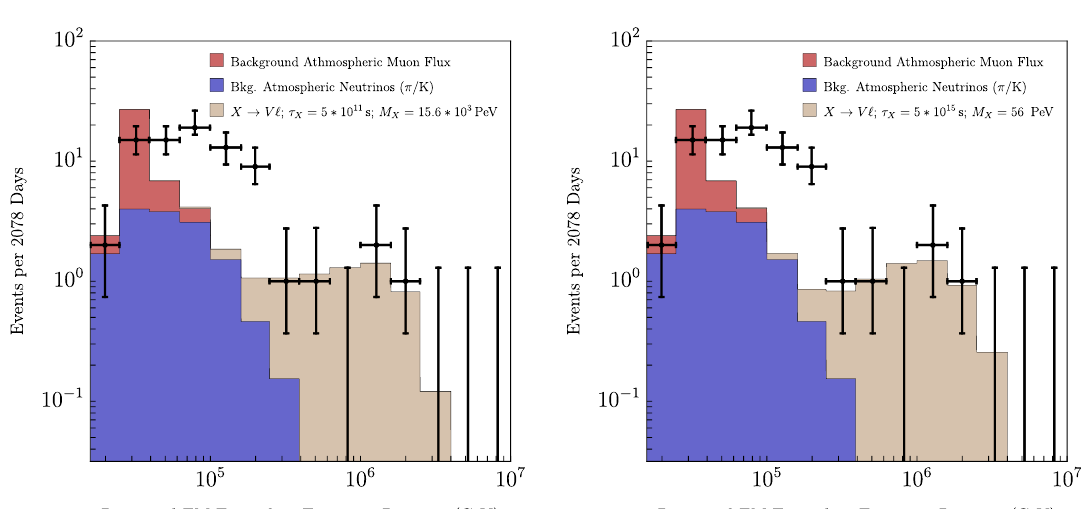
= 5 (cid:3) 10 15 s on the l